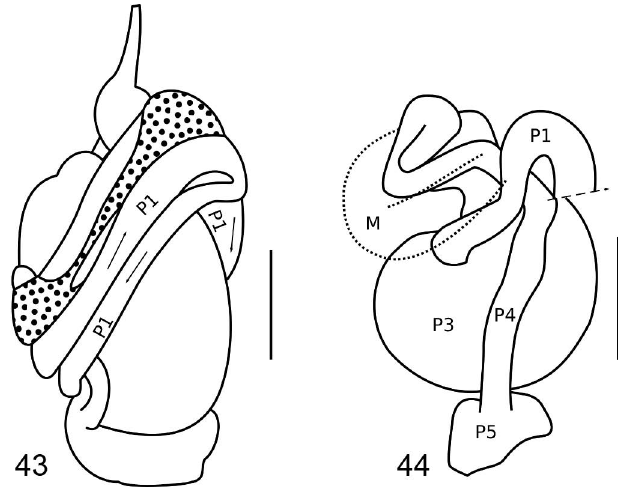
Figs 43–44. Worker gut in situ : 43- Caribitermes discolor , right view; 44- Parvitermes bacchanalis , dorsal view (the mesenteron position is indicated by the dotted lines, figures not to scale).